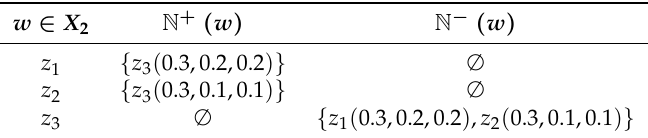
Table 4. IN-out and in-neighborhoods of −→ G 2